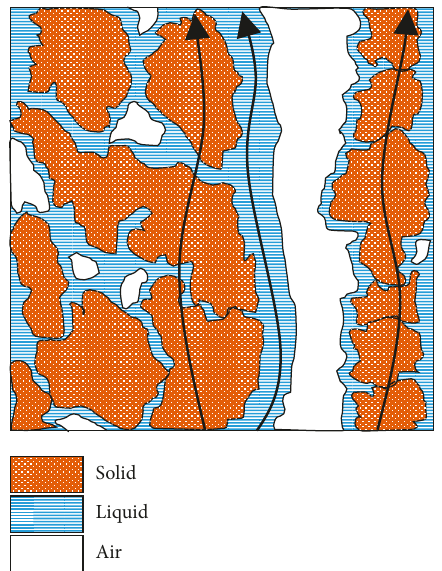
Figure 17: Schematic illustration of three electrical conductance elements in unsaturated soil: (a) solid-liquid series-coupled ele- ment, (b) liquid element, and (c) solid element.